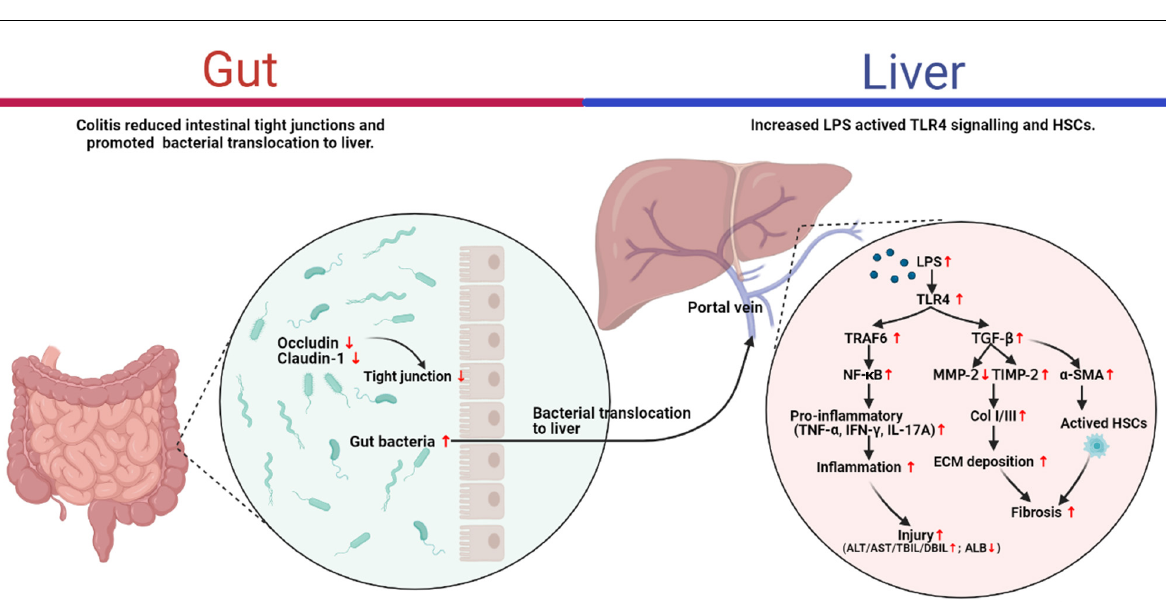
FIGURE 6 | Proposed mechanism for the ulcerative colitis-aggravated liver